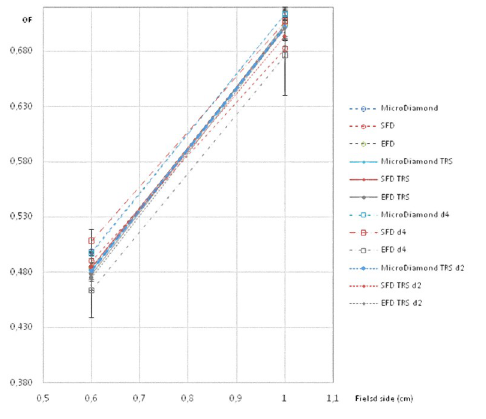
Fig 6. Ratio of detector readings and output factors for the 0.6 × 0.6 cm 2 and 1 × 1 cm 2 fields for the 6 FFF MV beams with different detectors, with daisy chaining in 4 x 4 cm 2 without correction and in 2 x 2 cm 2 with the TRS 483